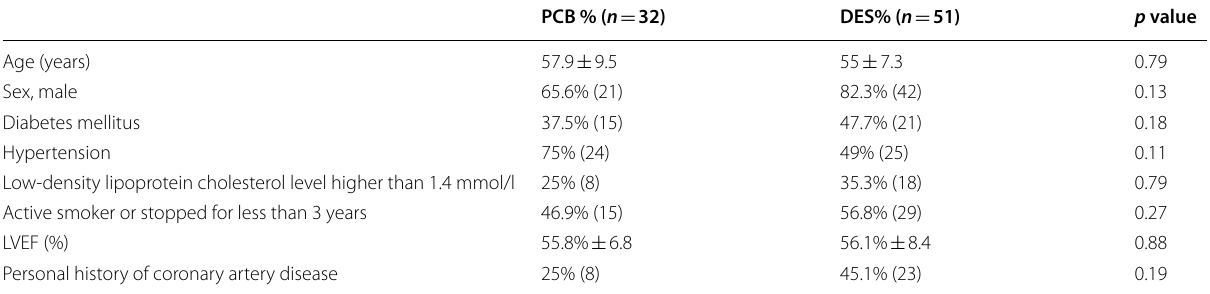
PCB Paclitaxel-coated balloon, DES Drug-eluting stent, LVEF Left ventricular ejection fraction